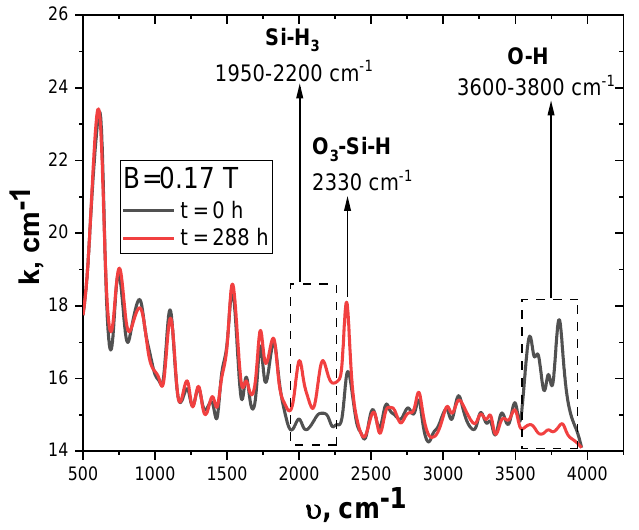
Figure 8. Infrared absorption spectra of the initial p-Si samples before and after 288 h of exposure to the magnetic field.